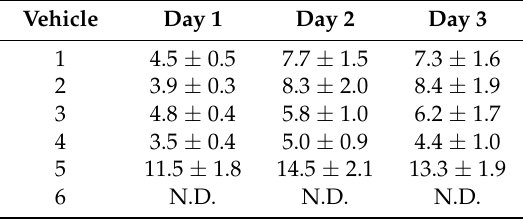
Table 8. Amount ( µ g/cm 2 ) of OMC delivered from the skin in the receiving medium after the removal of the vehicle in the repeated application protocol. N.D. = Not detectable in the receptor phase.